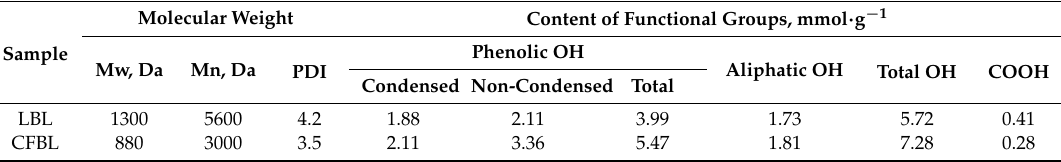
Table 1. Contents of functional groups in LBL and CFBL lignins measured by 31 P-NMR. MW: molecular